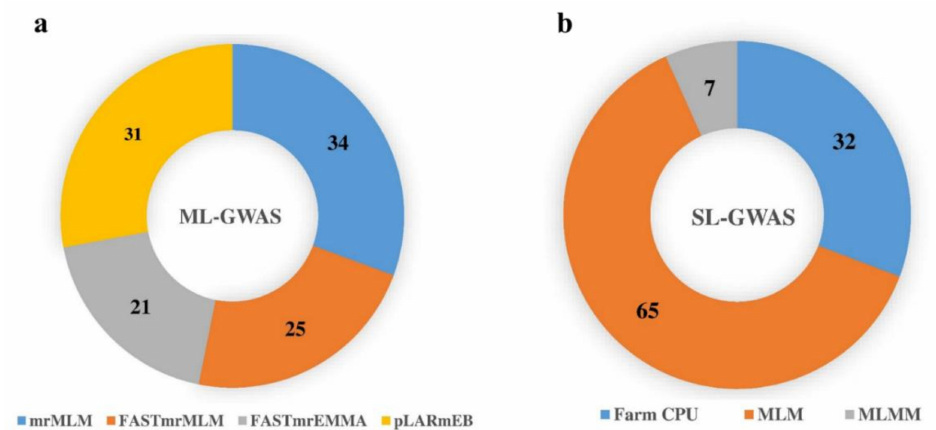
Figure 4. Significant SNPs detected by ML-GWAS vs. SL-GWAS methods: ( a ) the total number of significant SNPs detected by four ML-GWAs methods (mrMLM, FASTmrMLM, FASTmrEMMA, and pLARmEB); and ( b ) the total number of significant SNPs detected by three SL-GWAS methods (FarmCPU, MLM, and